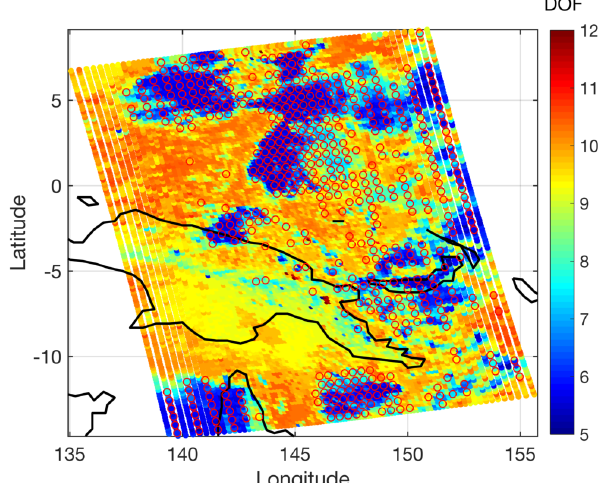
Figure 12. Retrieved degrees of freedom for Granule 039 show ev- ident dependence on observed BT1231 (which depends on cloud loading). The red circles denote locations of the AIRS FORs (fields of regard) (3 × 3) where the retrieval quality down to the surface is 2, meaning missing or do not use; this happened for 60% of the L2 FORs.